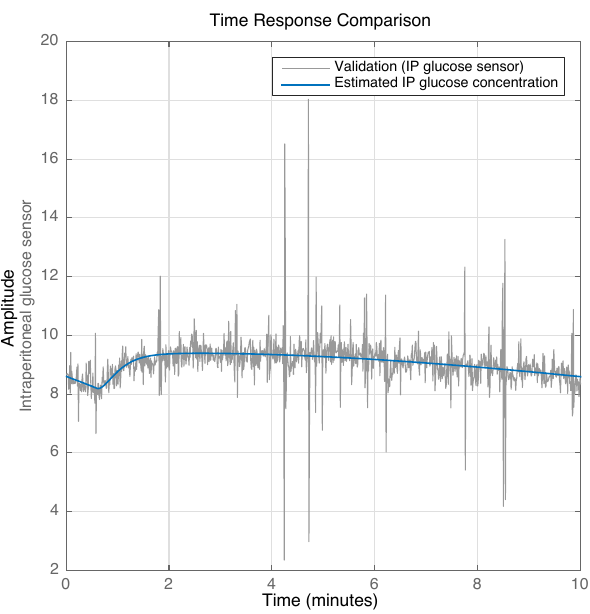
Figure 7: Example of identification of the dynam- ics H C ( s )H P ( s )h S , IP ( · ) from the glucose bo- lus to the peritoneal glucose concentration for segment 3C. The grey signal represents the IA sensor signal, while the blue signal shows a glucose bolus transferred through H C ( s )H P ( s )h S , IP ( · ). Beware that the verti- cal axis has no unit, since the signals are un- calibrated. Copyright: CC BY-NC-SA